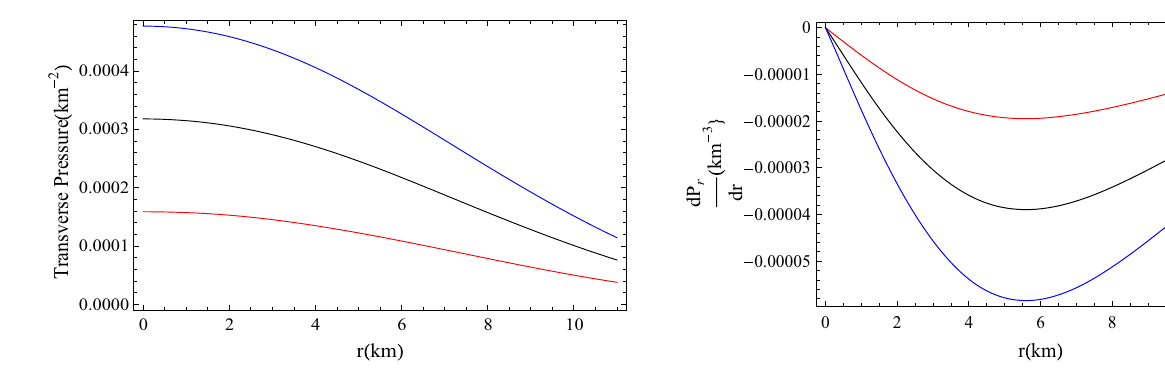
Fig. 4 Variation of transverse pressure with r of PSR J0348+0432 for β = 1 (red), β = 2 (black) and β = 3 (blue) (considering α = 0 . 4)